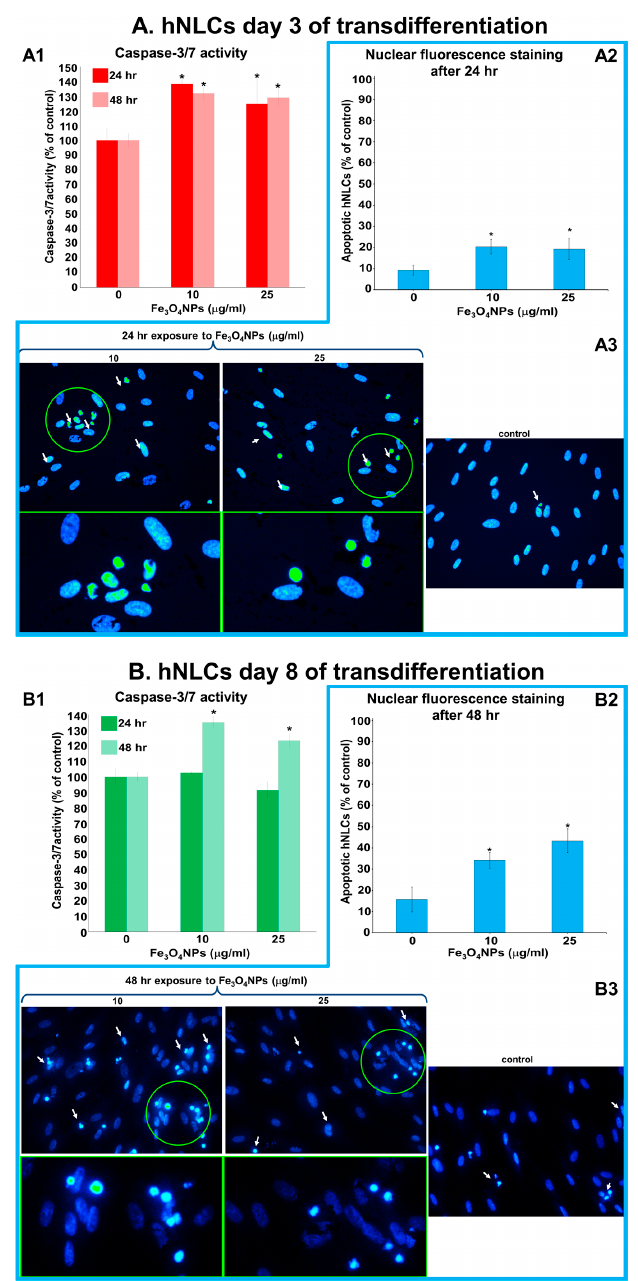
Figure 8. Caspase-3 / 7 activity and apoptotic cells evaluation after exposure to Fe 3 O 4 NPs (10 and 25 µ g / mL). ( A ) Composite images that display the caspase-3 / 7 activity evaluated after 24 and 48 h exposure to Fe 3 O 4 NPs ( A1 ) and apoptotic cells detected by Hoechst 33258 staining after 24 h exposure to Fe 3 O 4 NPs in hNLCs at day 3 of transdi ff erentiation ( A2 , A3 ). ( B ) Composite images that show the caspase-3 / 7 activity evaluated after 24 and 48 h exposure to Fe 3 O 4 NPs ( B1 ) and apoptotic cells detected by Hoechst 33258 staining after 48 h to Fe 3 O 4 NPs in hNLCs at day 8 of transdi ff erentiation ( B2 , B3 ). The caspase-3 / 7 activity of the control cells was set to 100% and the data are expressed as mean ± S.D. * p < 0.05. Statistical analysis by two-way ANOVA followed by Dunnett’s test. Apoptotic cells were expressed as % of total cell counted. Data represent the mean ± S.D. * p < 0.05. Statistical analysis by two-way ANOVA followed by Dunnett’s test. Representative images in fluorescence microscope are taken using magnification 40 × , the areas indicated by the circle show the magnification 2.5-fold. Arrows indicate nuclear morphological changes such as chromatin condensation, fragmentation, and formation of apoptotic